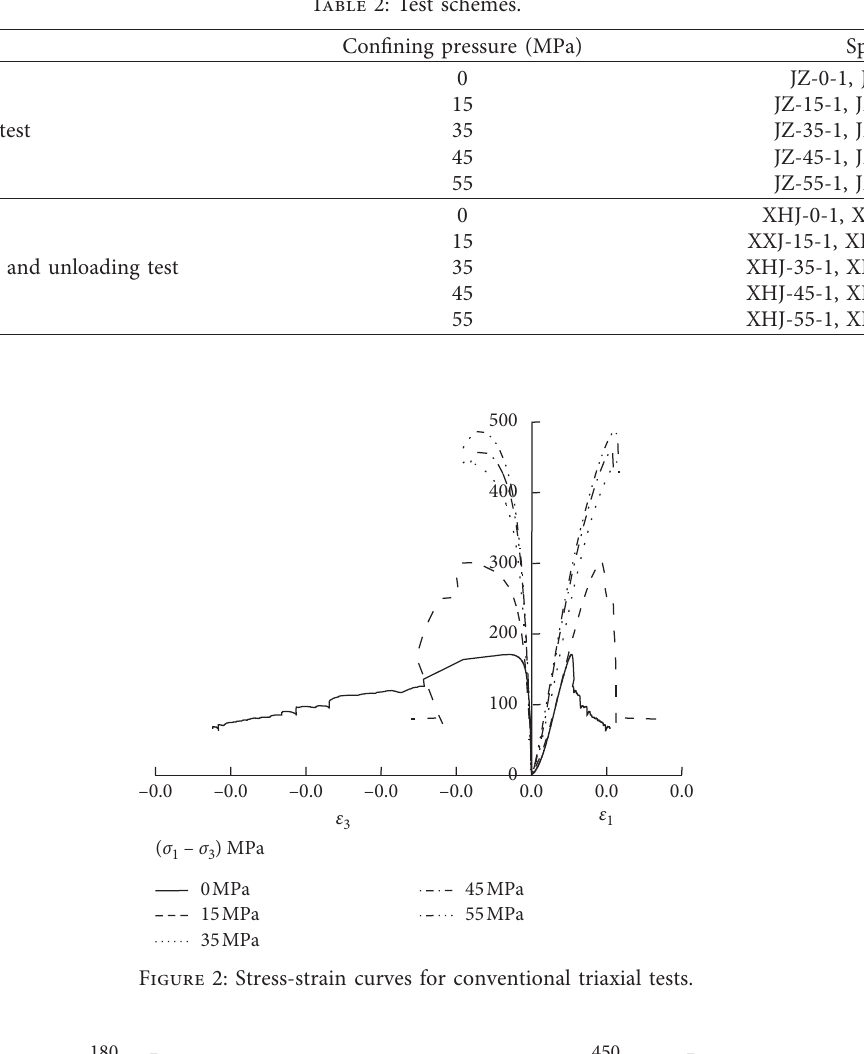
Table 2: Test schemes.